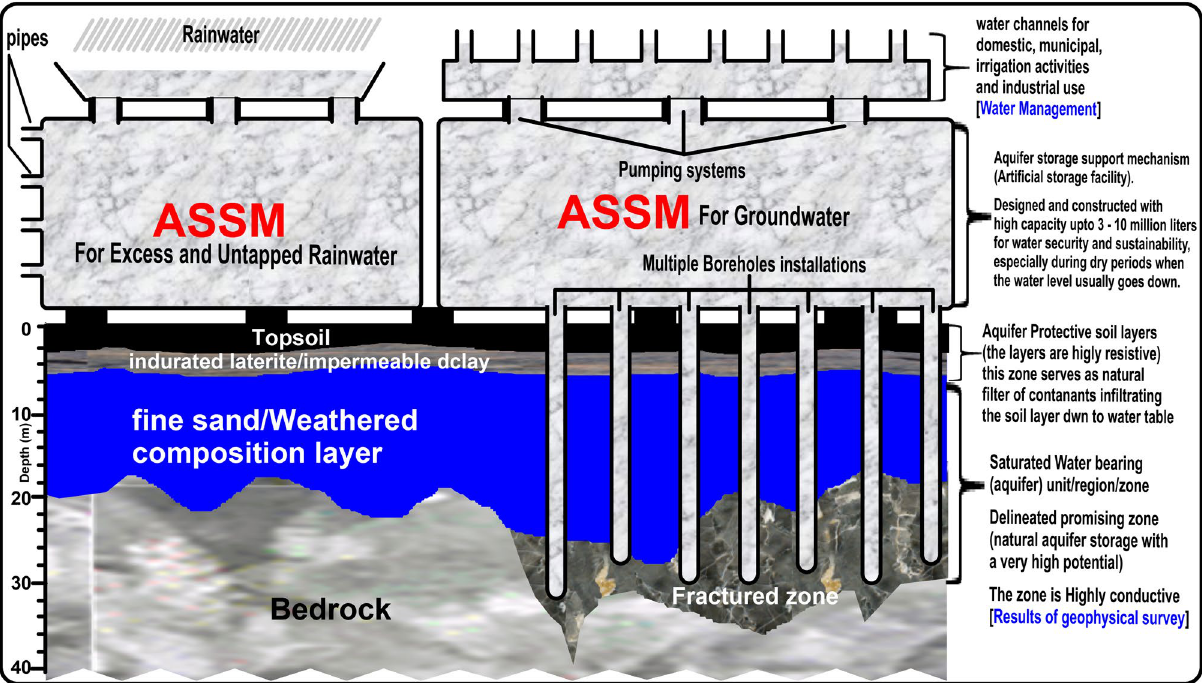
Fig. 8 Aquifer promising zones and alternative/artificial storage support